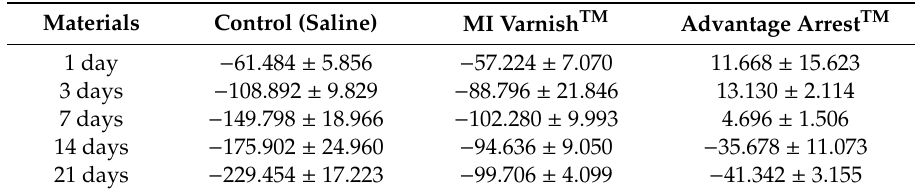
0–20 µ m after several treatment durations with the three tested materials.